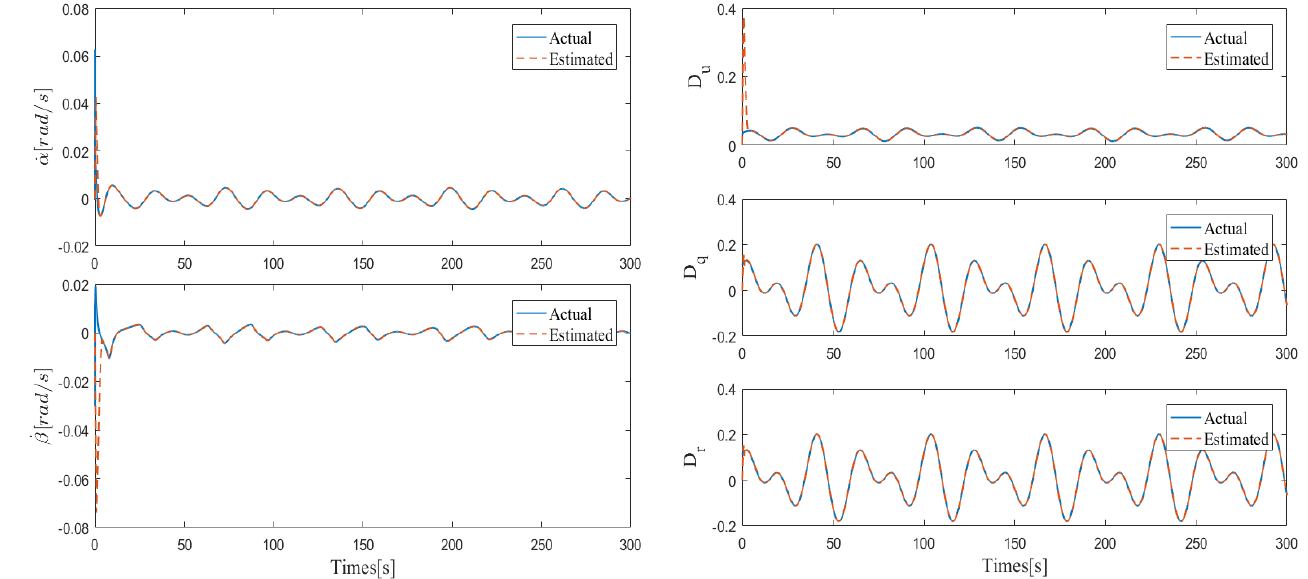
Figure 13. The unknown cuncertainties estimation of Case 2.